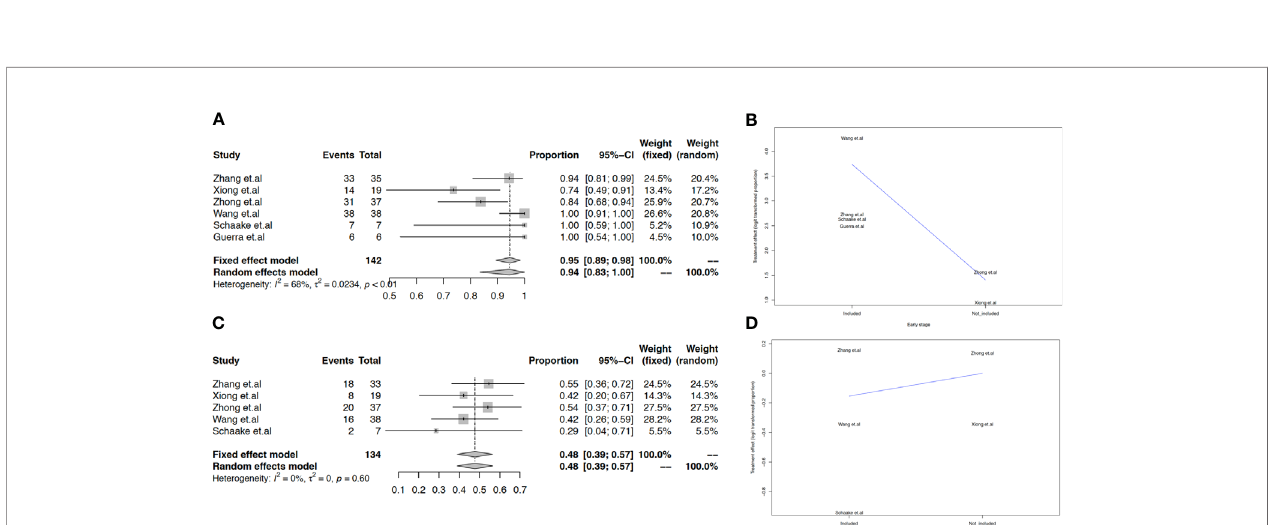
FIGURE 2 | Meta-analysis and meta-regression analysis of surgical rate and ORR. The pooled surgical rate in the population with EGFR-TKI-sensitive mutations (A) ; meta-regression analysis of the surgical rate based on different advanced stages (B) ; the pooled ORR in the population with EGFR-TKI-sensitive mutations (C) ; meta-regression analysis of ORR based on different TNM stages (D)